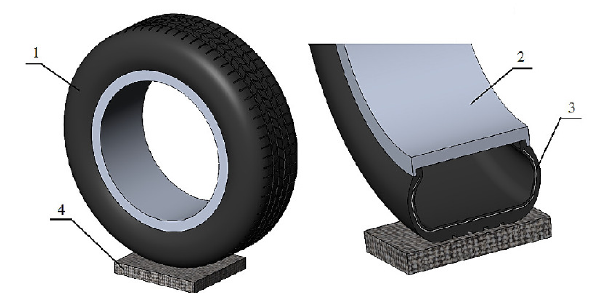
Figure 3. Geometry of the model: 1—tyre, 2—rim, 3—elastic insert and 4—road surface.